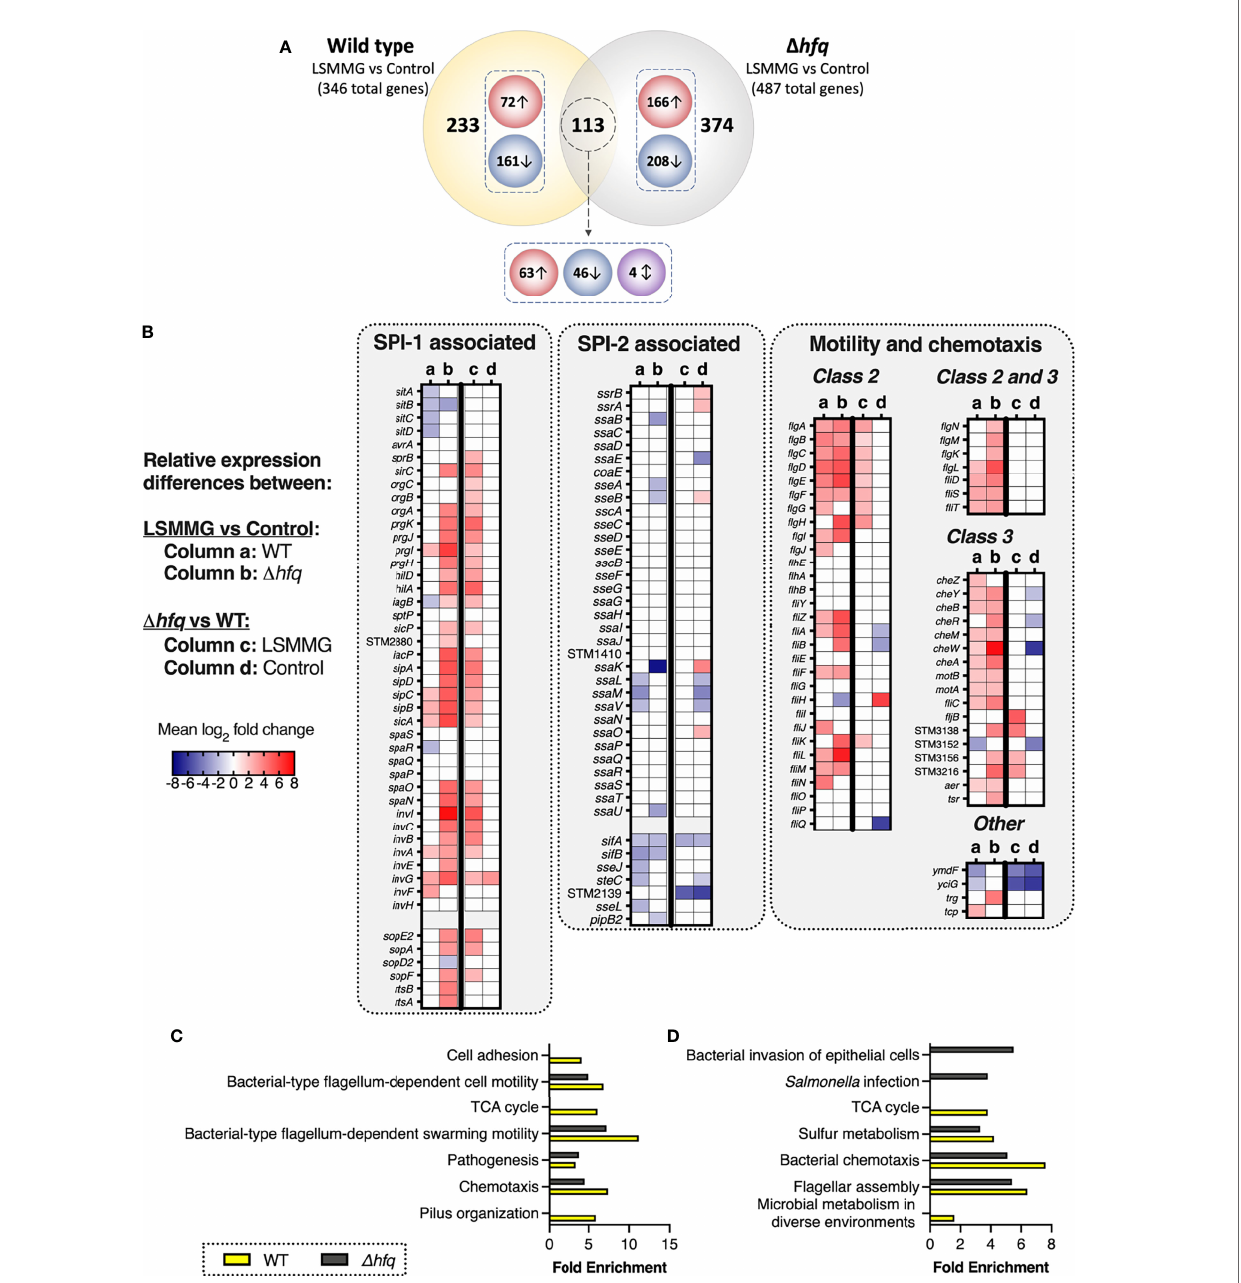
FIGURE 3 | LSMMG-regulated genes in wild type and D hfq S . Typhimurium. Bacteria were cultured in RWVs positioned in the LSMMG or control orientations and analyzed using RNA-seq. Experiments were performed in biological triplicate for each strain (N = 3). Transcripts used in these analyses displayed a log 2 fold change (logFC) of at least ± 1 and a false-discovery rate (FDR) of < 0.05. (A) Venn diagram depicting the numbers of distinct and common differentially expressed genes between WT and the D hfq mutant in response to LSMMG culture relative to their respective controls. Red circles indicate numbers of upregulated genes, blue circles indicate downregulated genes and the purple circle indicates genes oppositely regulated between wild type and mutant in response to LSMMG culture. (B) Heat maps highlighting differentially expressed genes associated with SPI-1, SPI-2 and motility/chemotaxis. Columns (a) and (b) indicate logFC in LSMMG cultures relative to controls for the wild type or mutant, respectively. Columns (c) and (d) indicate logFC in the mutant relative to wild type for either only the LSMMG cultures or only the control cultures, respectively. Mean logFC values are blue to indicate downregulation and red to indicate upregulation. White indicates no change for the indicated comparison. (C ‐ D) Enrichment analysis of WT (yellow bars) and D hfq (gray bars) transcriptomic data between LSMMG and control cultures. Biological processes are shown in panel (C) and Kegg pathways in panel (D) Differentially regulated transcripts were analyzed using DAVID 6.8 (Huang et al., 2008) using a threshold count of 2, an EASE score of 0.05 and Benjamini-Hochberg correction (<